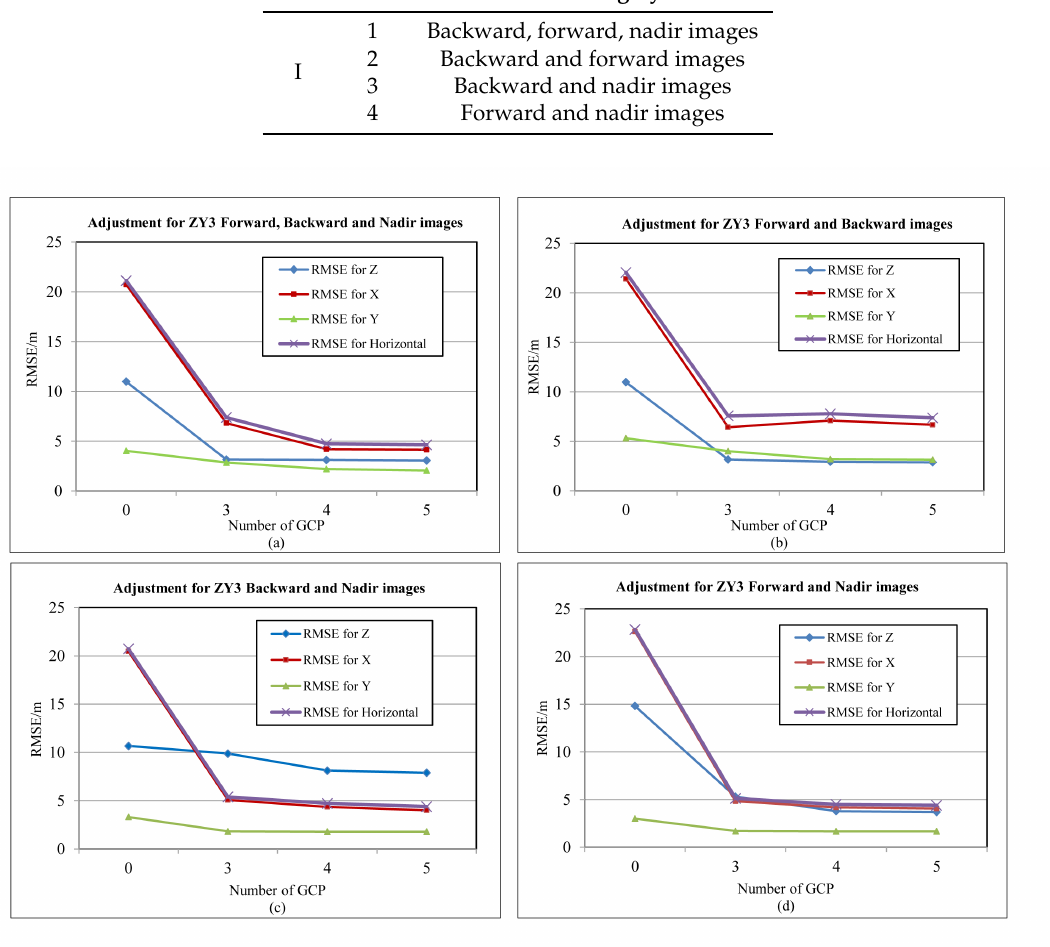
Figure 6. Result of conventional image positioning with different numbers of GCPs using ZY-3 images: ( a ) accuracy of adjustment for forward, nadir and backward images with different number of GCPs; ( b ) accuracy of adjustment for backward and forward images with different number of GCPs; ( c ) accuracy of adjustment for backward and nadir images with different number of GCPs; ( d ) accuracy of adjustment for forward and nadir images with different number of